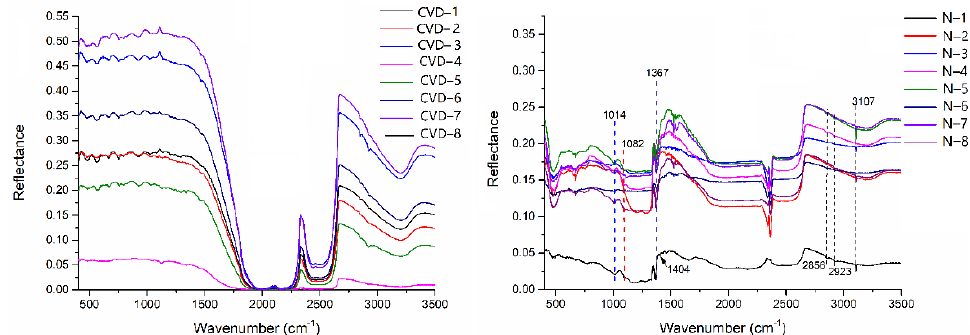
Figure 4. Infrared spectra of CVD synthetic diamonds and natural diamonds.